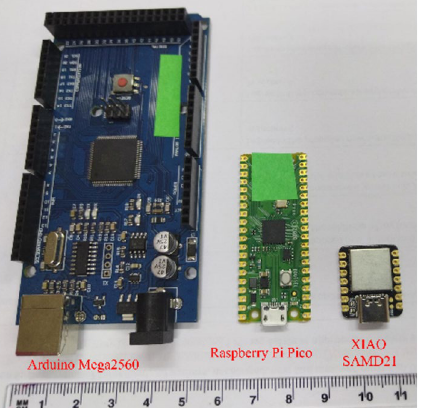
Figure 1. Used embedded-hardware platforms: Arduino Mega2560, Raspberry Pi Pico and XIAO